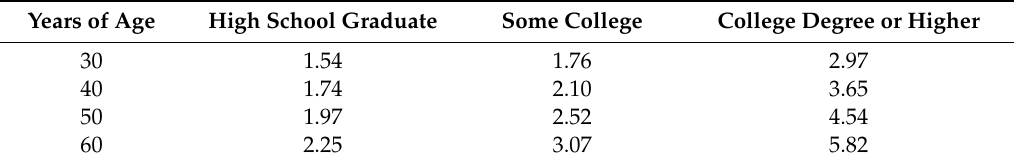
Table 2. Ratio of Earnings of Some College or College Completion Relative to No High School Completion at Selected